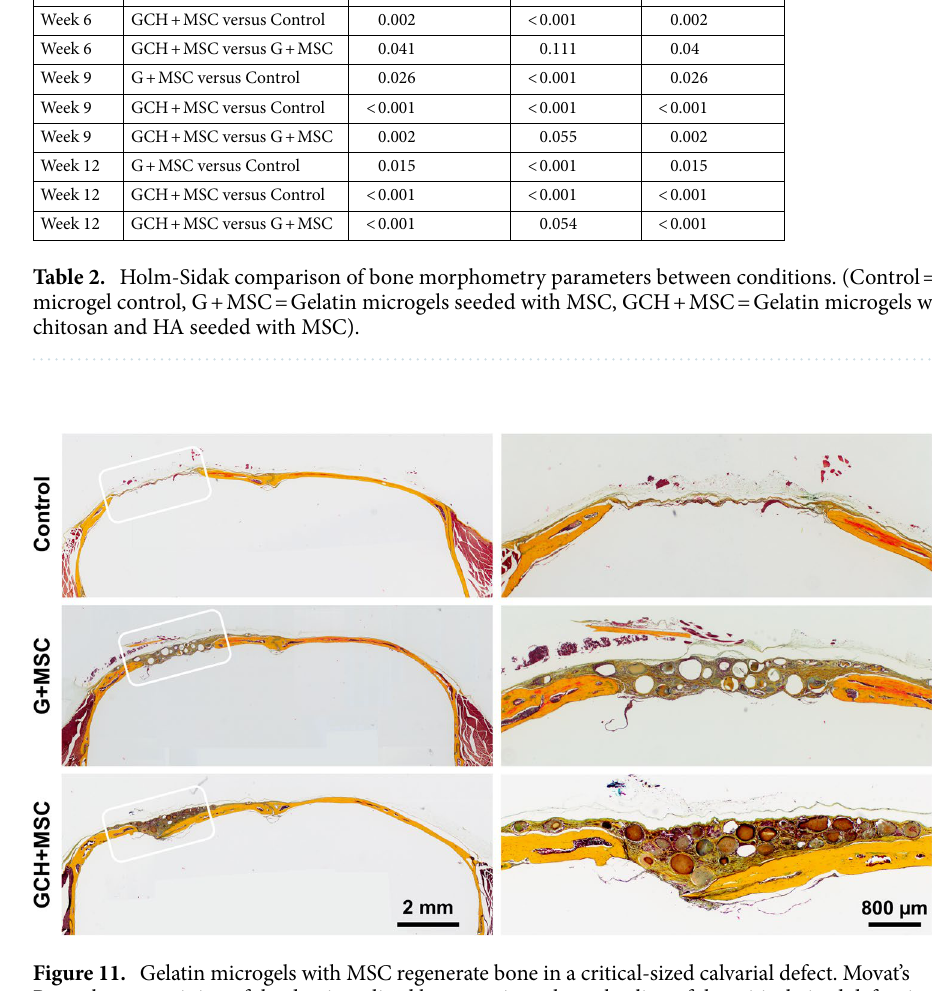
Figure 11. Gelatin microgels with MSC regenerate bone in a critical-sized calvarial defect. Movat’s Pentachrome staining of the demineralized bone sections shows healing of the critical-sized defect in various treatment conditions. A yellow stain indicates collagen fibers, and a black stain indicates elastic fibers. (Left) The control condition showed no bridging, while the gelatin microgels seeded with MSC showed partial bridging with collagen and elastic fibers. The gelatin-chitosan-HA microgels exhibited the highest bridging with the osteoid formation and collagenous matrix deposition. (Right) Magnified images of the defect area of corresponding treatments shown on the left.